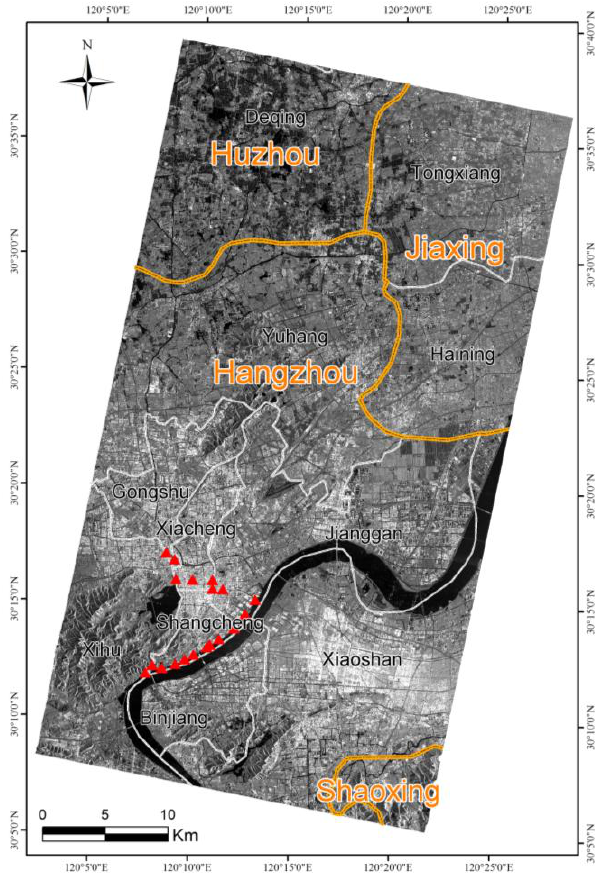
Figure 1. The average amplitude image of 29 TerraSAR-X images and the distribution of levelling points (red triangle)